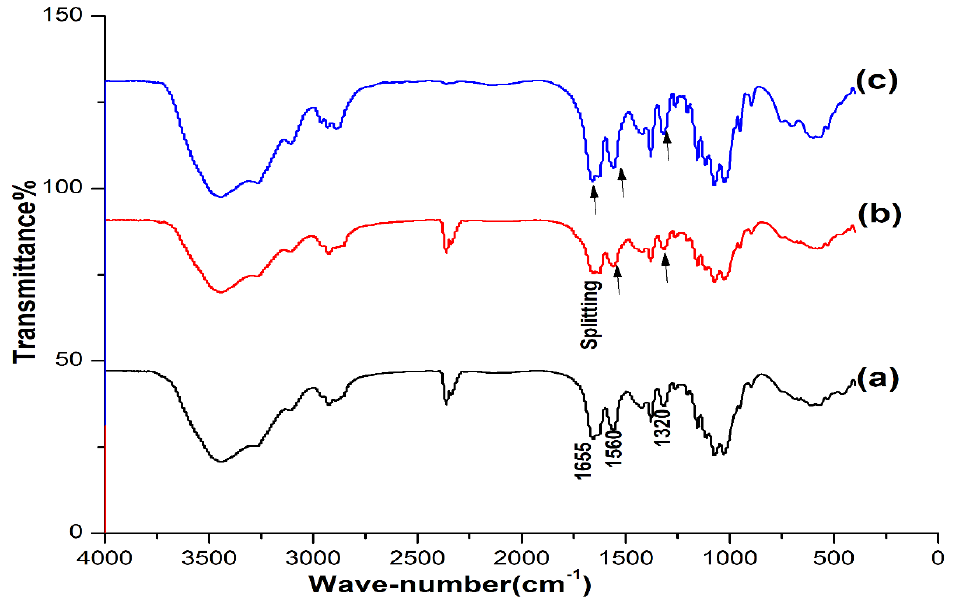
Figure 1. IR spectra of the one-step extracted P. americana chitin ( a ), crab chitin ( b ) and shrimp chitin ( c ). High similarity was observed between the three samples.